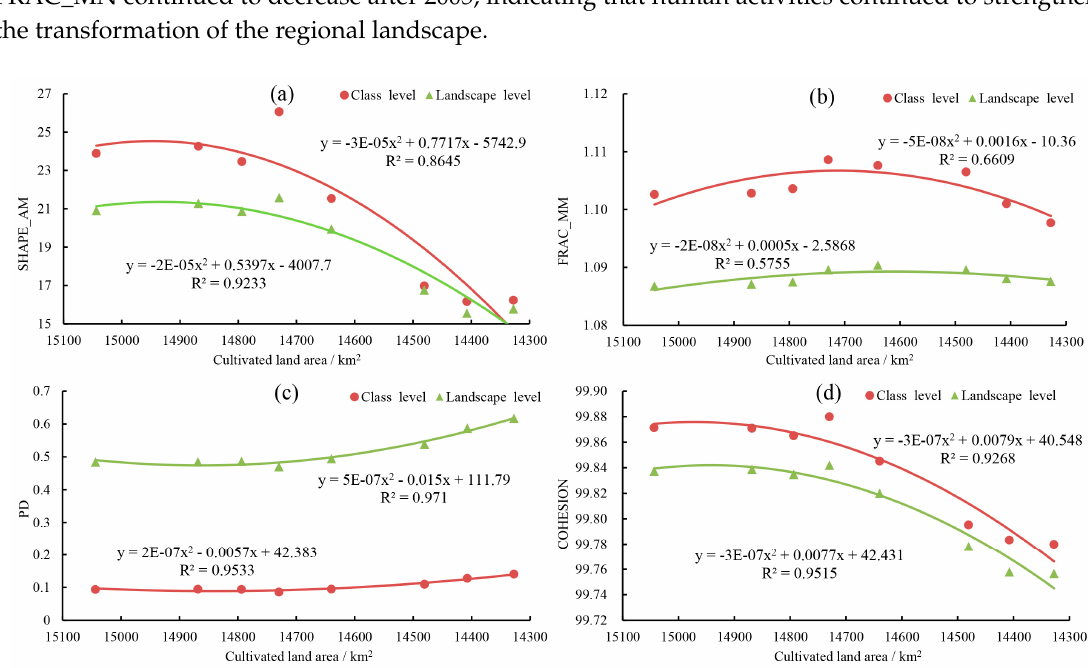
Figure 7. Relationship curve between landscape pattern index and cultivated land area by static window method. ( a ) SHAPE_AM, area-weighted mean shape index; ( b ) FRAC_MN, mean fractal dimension index; ( c ) PD, patch density; ( d ) COHESION, patch cohesion index.